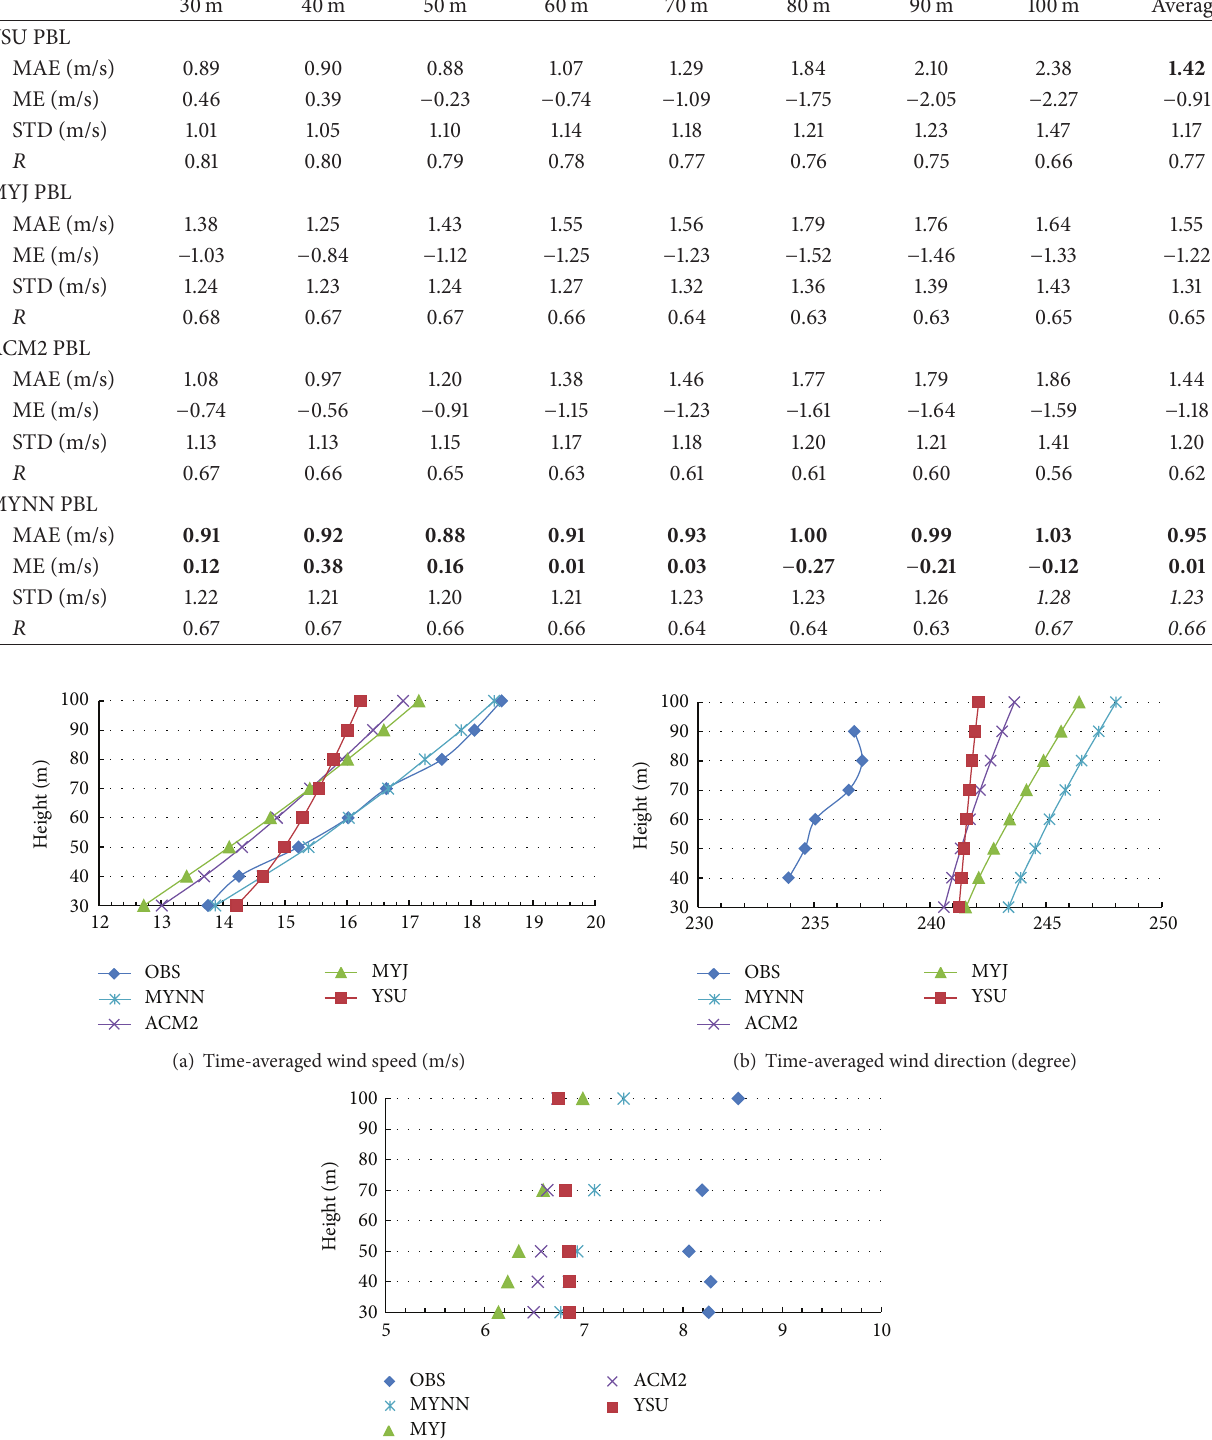
Table 5: Statistical metrics (MAE in m/s, ME in m/s, STD of the ME in m/s, and 𝑅 ) for the wind speed at 8 vertical levels (30–100 m), so as to evaluate the performance of four PBL schemes (YSU, MYJ, ACM2, and MYNN) at the 3 km WRF modelling domain.